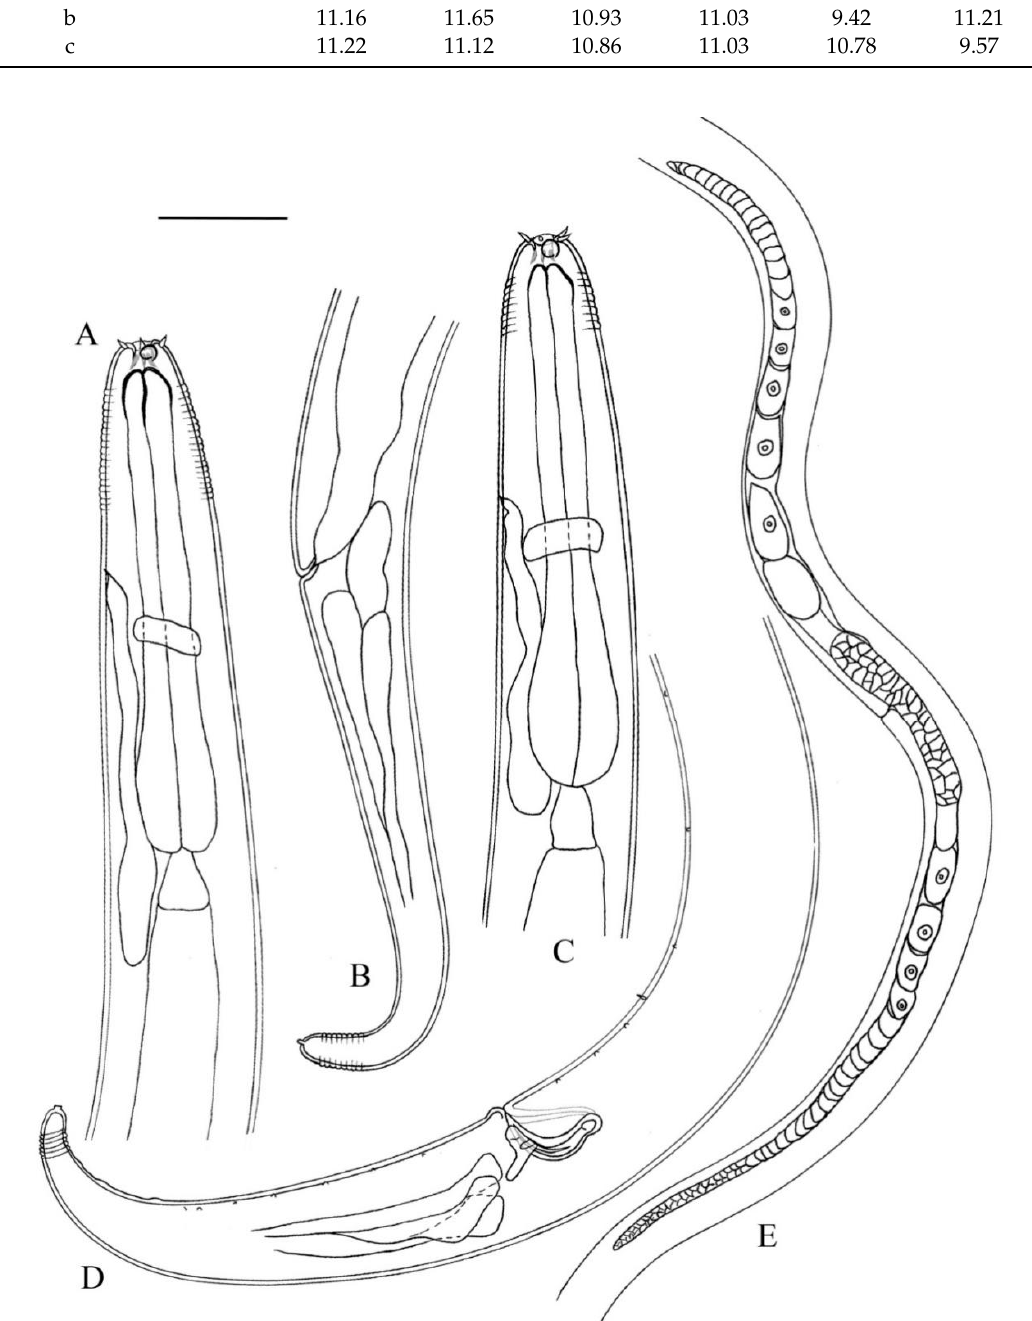
Figure 3. Anticyathus communis sp. nov.—holotype male and paratype female in lateral view. ( A ) lateral view of female head end; ( B ) lateral view of female tail; ( C ) lateral view of male head end; ( D ) lateral view of male tail region; ( E ) lateral view of female body part, showing ovaries. Scale bar: ( A – D ) = 50 µm; ( E ) = 125 µm.